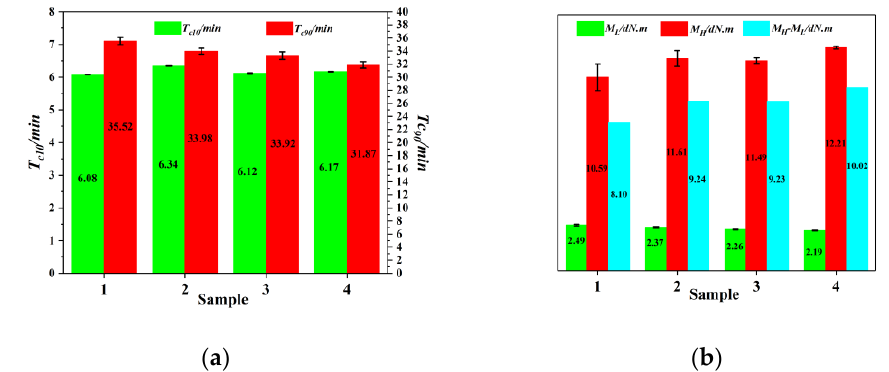
Figure 7. The curing characteristics of rubber: ( a ) The scorch time ( T c10 ) and curing time ( T c90 ); ( b ) The minimum torque ( M L ), maximum torque ( M H ) and torque difference ( M H -M L ); (1) SiO 2 /EUG/SBR; (2) MEST-SiO 2 /EUG/SBR; (3) SiO 2 /EEUG/EUG/SBR; (4) MTES-SiO 2 /EEUG/EUG/SBR.